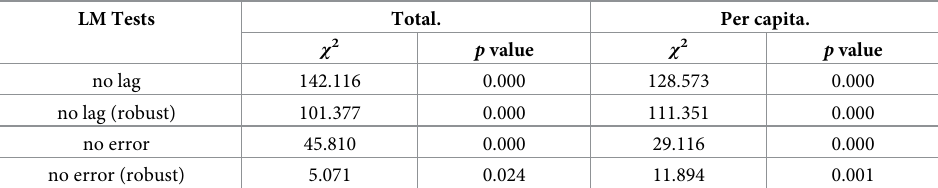
Table 4. Results of LM tests for the spatial panel